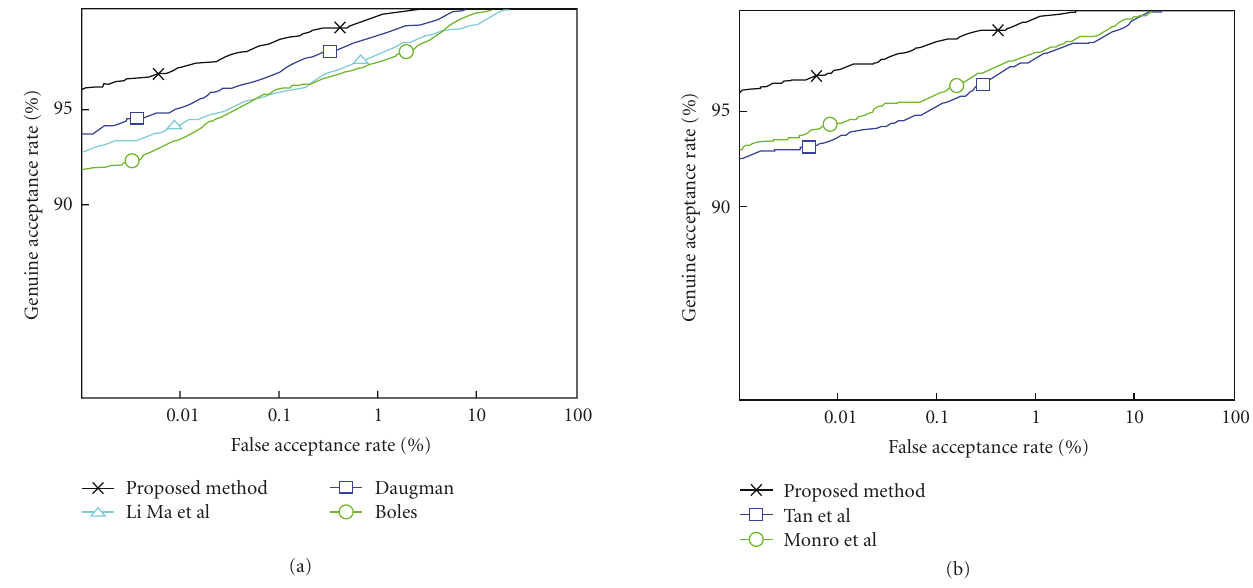
Figure 19: ROC curves of proposed method in comparison with (a) Boles and Boashash [10], Daugman [5], Ma et al. [7], and (b) Monro et al. [15], Halligswroth et al. [27] methods using Bath iris database.